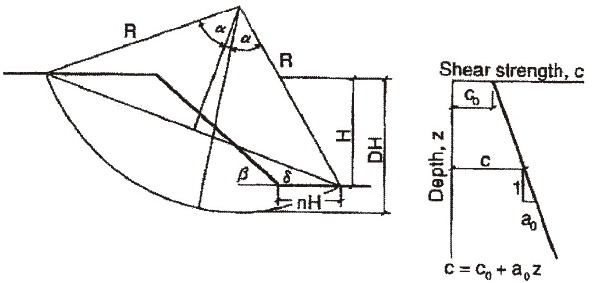
Fig. 8. A typical slope section and slope stability parameters (MERM,